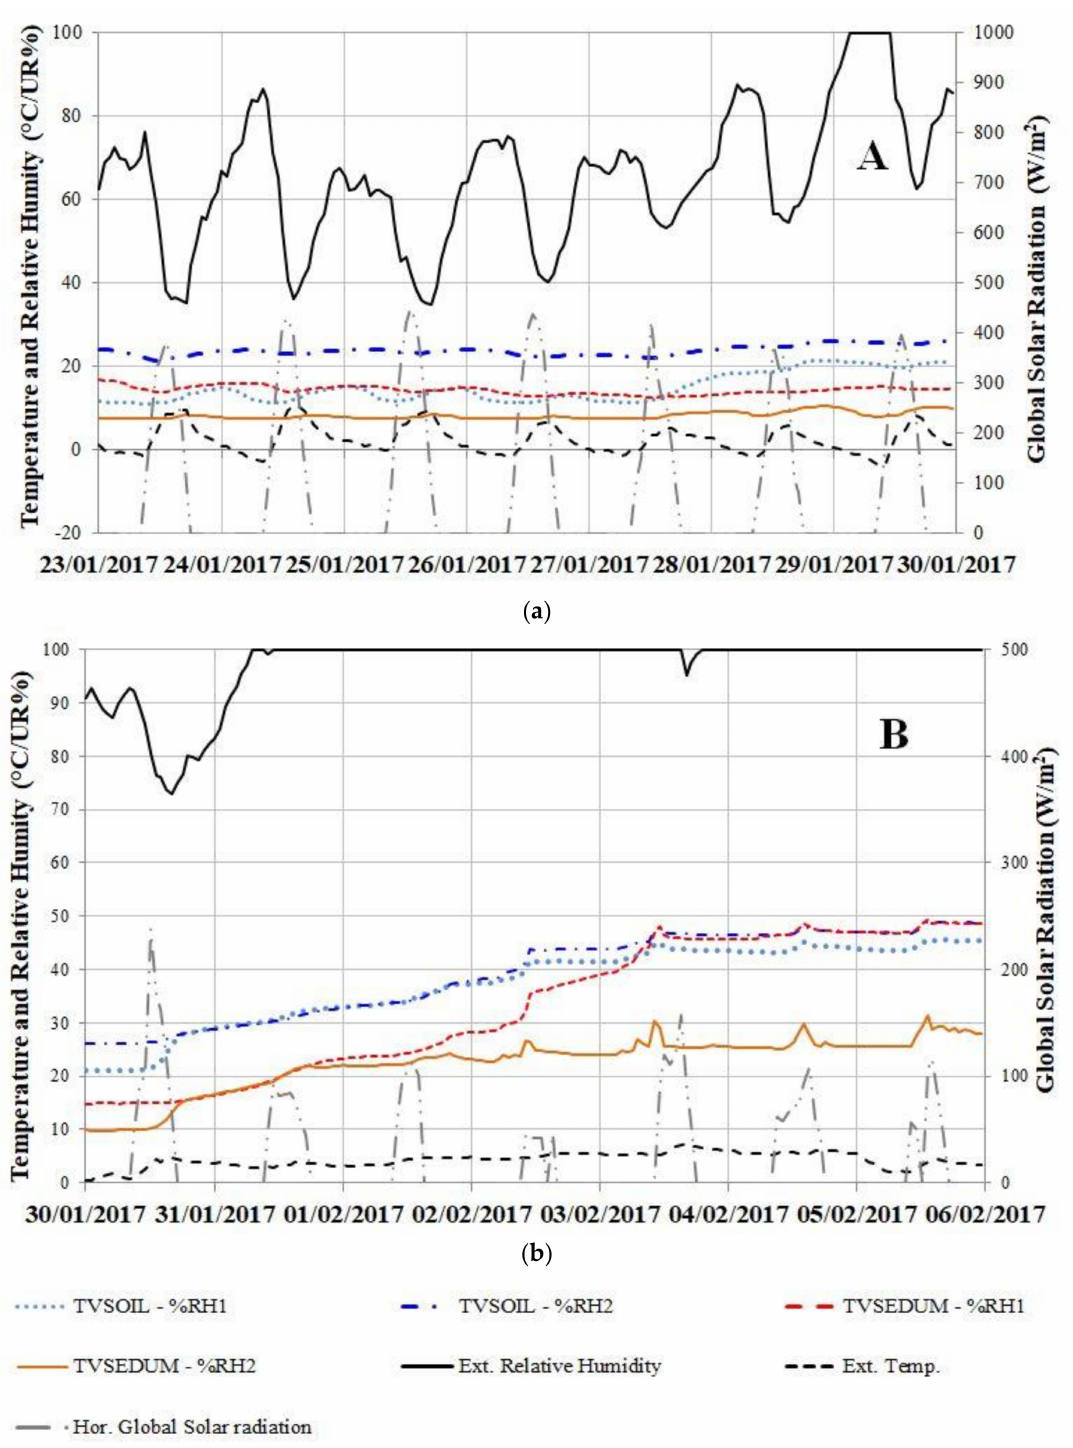
Figure 11. Internal moisture content of growing media for the week from 23 January to 29 January 2017 ( a ); and the week from 30 January to 6 February 2017 ( b ) with TVSOIL and